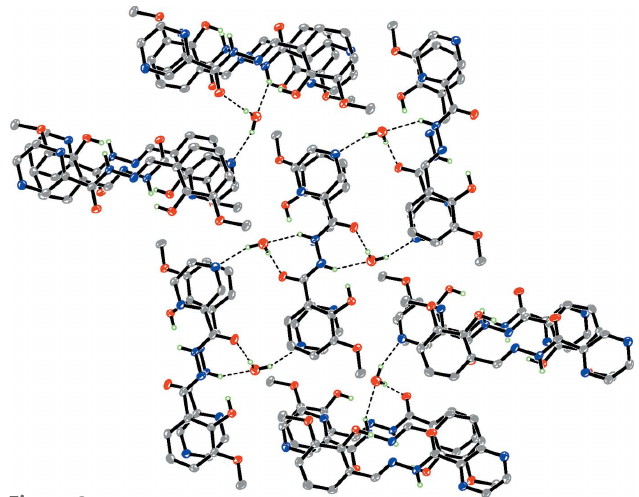
Figure 2 The crystal packing viewed along the -axis direction.